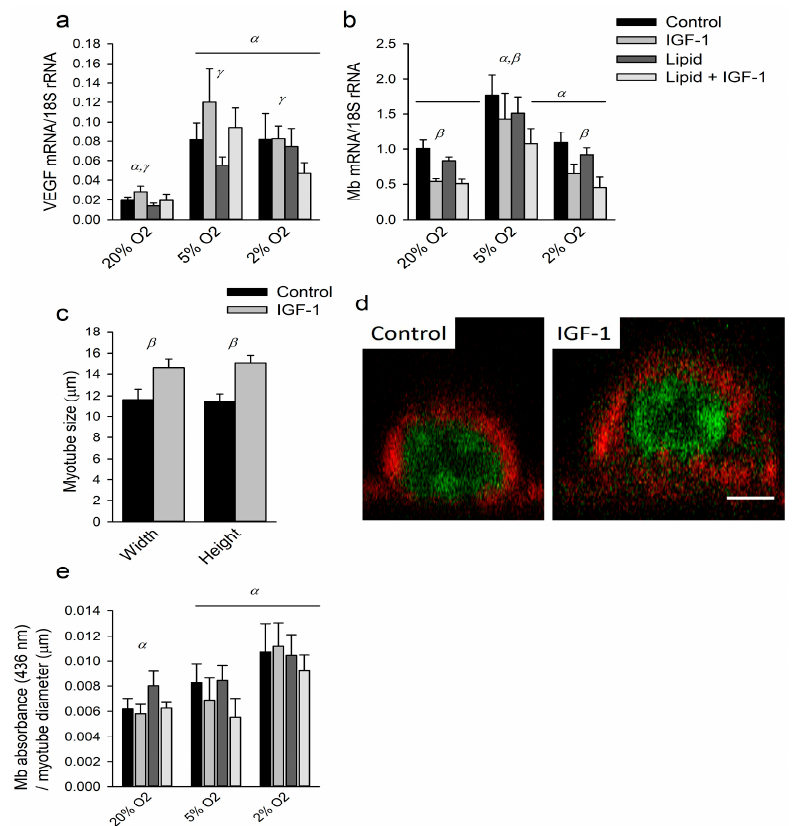
Figure 4. IGF-1 lowers myoglobin (Mb) mRNA expression but not Mb protein concentration in the cells: ( a , b ) mRNA expression levels of vascular endothelial growth factor (VEGF) and Mb for myotubes cultured the last 24 h of differentiation under different oxygen tensions, with and without IGF-1 and lipid; ( c ) in a separate experiment, height and width of myotubes was measured ( n = 20 myotubes); ( d ) representative examples of cross-sections of individual myocytes live stained in red for F-actin and in green for DNA (scale bar represents 5 µ m); and ( e ) absorbance due to Mb peroxidase activity normalized by myotube diameter as a measure of concentration. α : significant effect of oxygen tension compared to other O 2 tensions denoted with α ; β significant overall effect of IGF-1 treatment; γ : significant overall effect of lipid supplementation. Although β and γ designate an overall effect, for clarity symbols are placed above every oxygen tension. Values are given as mean ± SEM, n = 6.